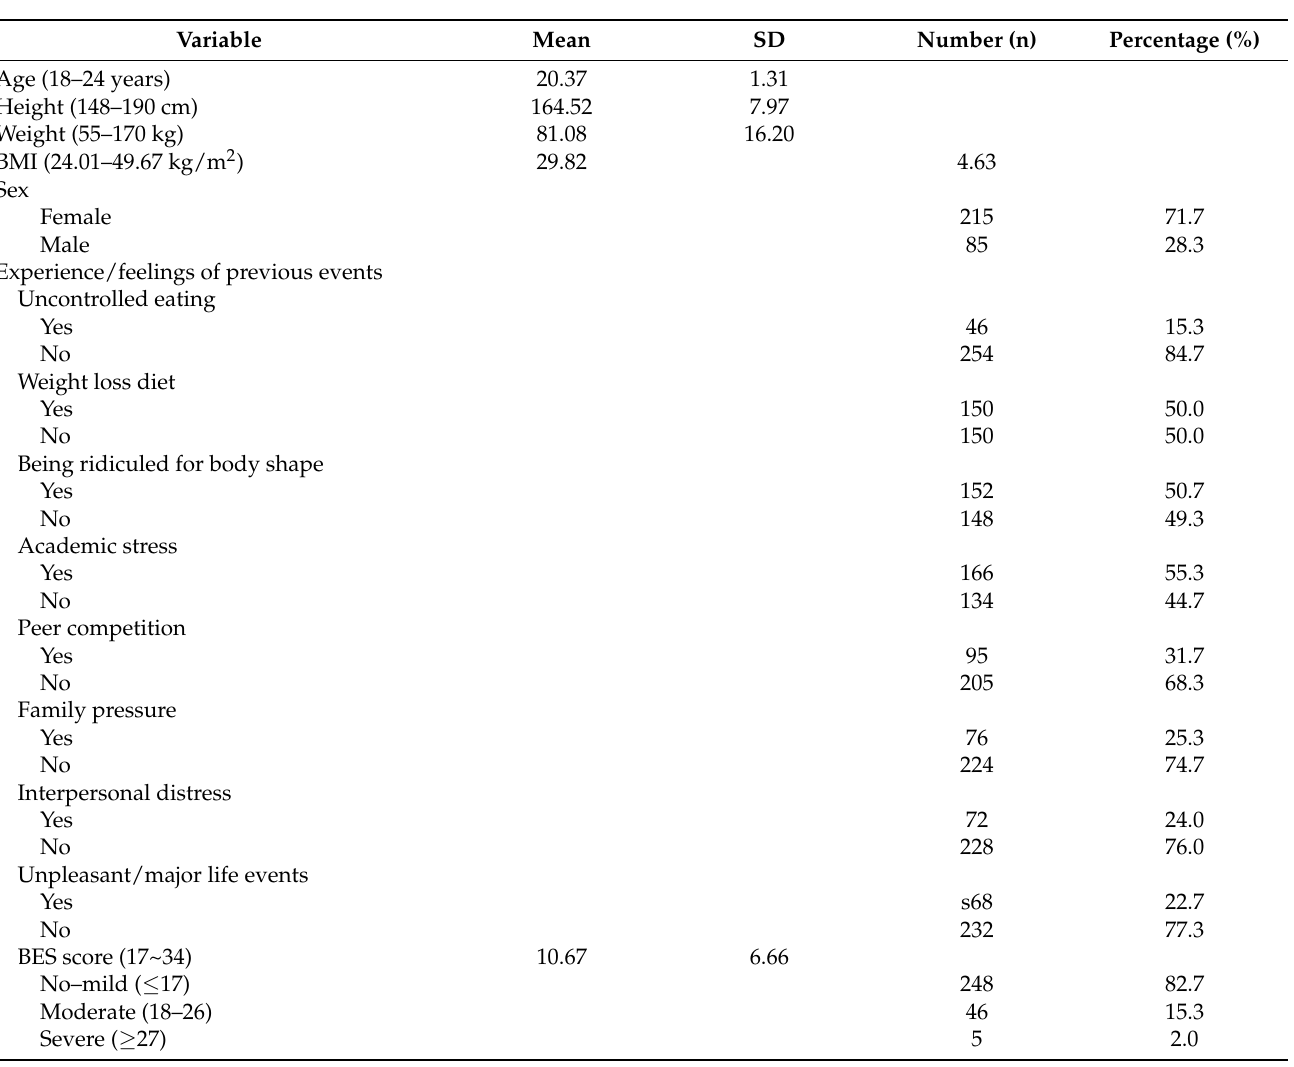
Table 1. Demographic and psychosocial variables (n = 300).